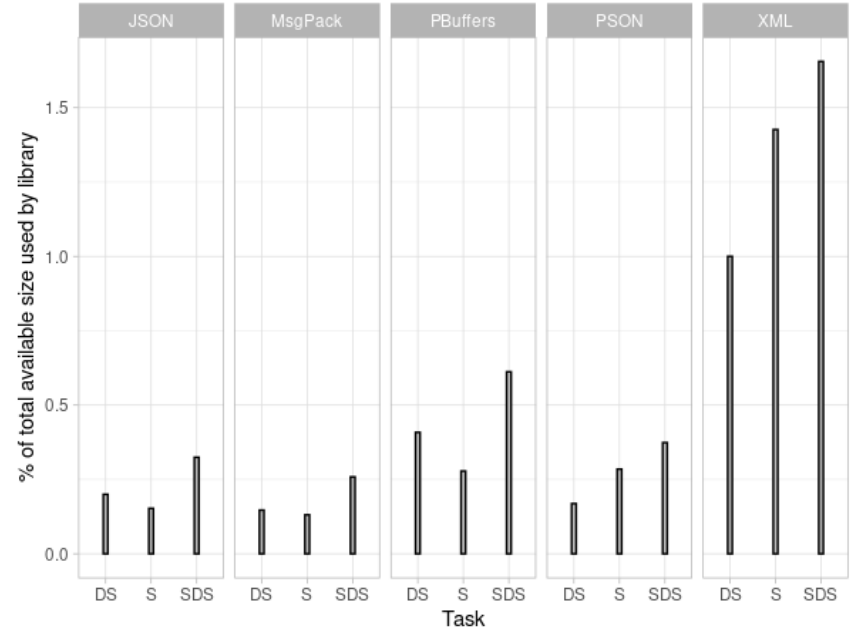
Figure 5. ESP32 binary size